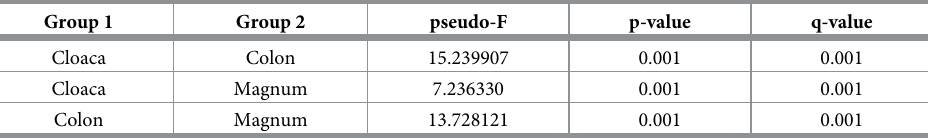
Table 3. Pairwise PERMANOVA results based on unweighted unifrac distance